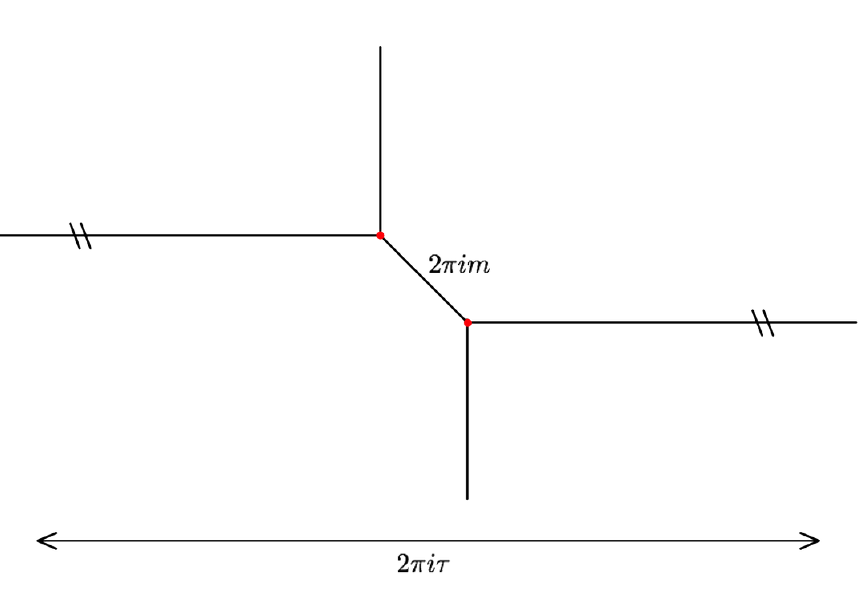
Figure 4 . Toric diagram for the geometry that engineers the N = 2 (cid:3) U(1) theory in (cid:12)ve